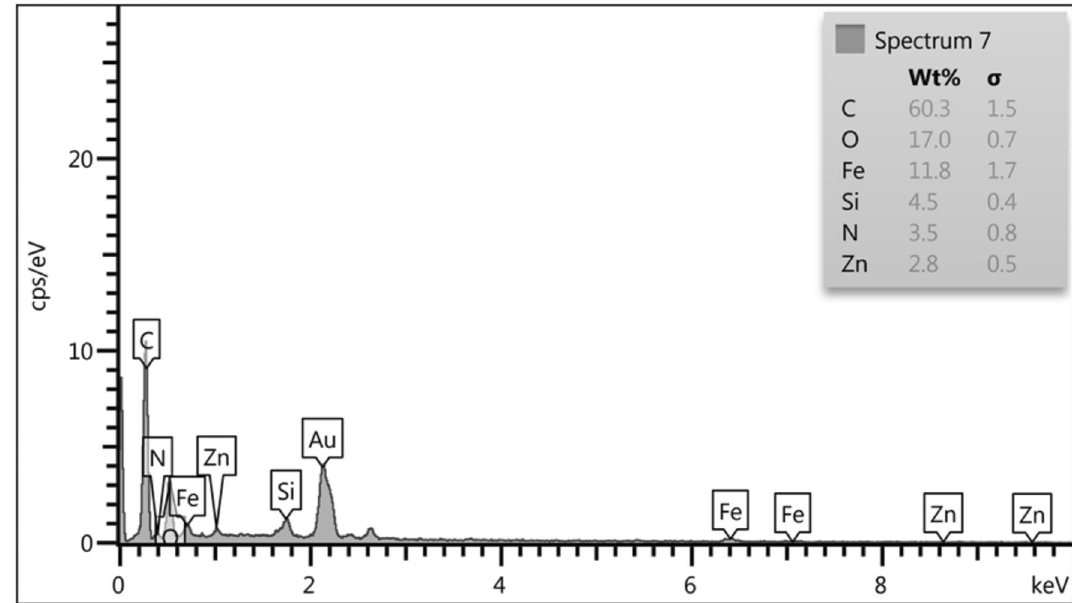
Figure 3. EDX analysis of prepared hybrid by 1,4-phenylenediamine and terephthaloyl chloride on the magnetic ZnFe 2 O 4